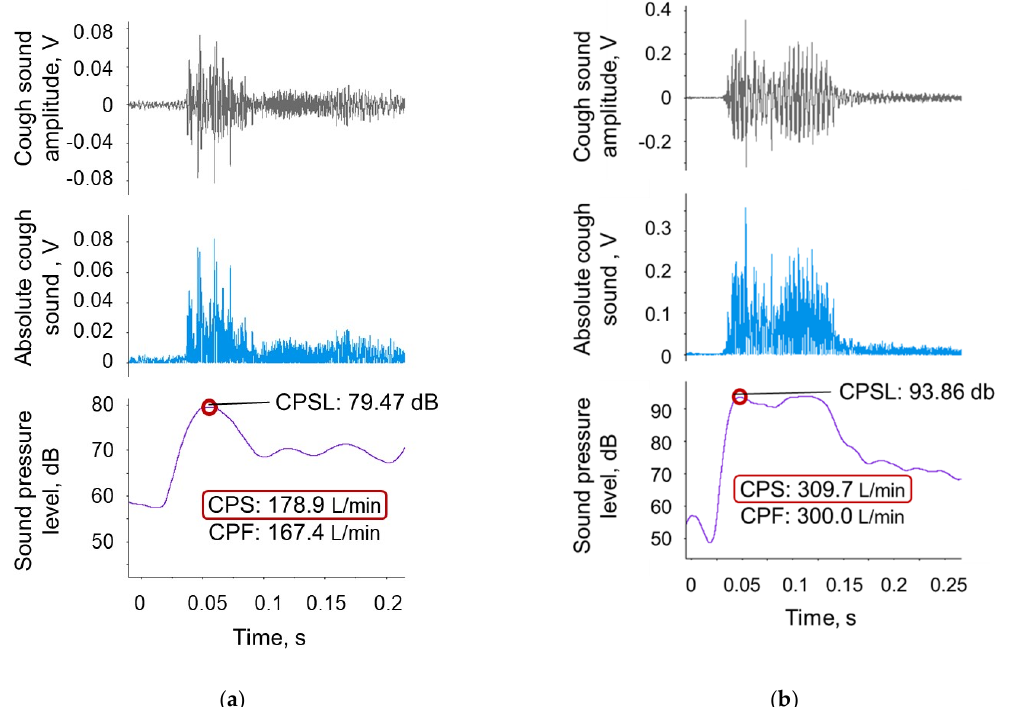
Figure 6. Examples of cough sound patterns in elderly participants [58]. The grey line represents the measured cough sound signal. The solid light blue line represents the bandpass-filtered and rectified sound signal. The solid purple line represents the moving average with a time window of 20 ms. The red circle represents the maximum point of the moving average. ( a ) Example of a 77-year-old woman with a measured CPF below the reference value of 270 L/min. The respiratory function test showed slightly low values of %Vital Capacity (VC) = 83.5% and one second/forced vital capacity (FEV1/FVC) = 83.0%. ( b ) Example of a 70-year-old man with a measured CPF above the reference value of 270 L/min. The respiratory function test showed normal values of %VC = 91.6% and FEV1/FVC = 94.9%.